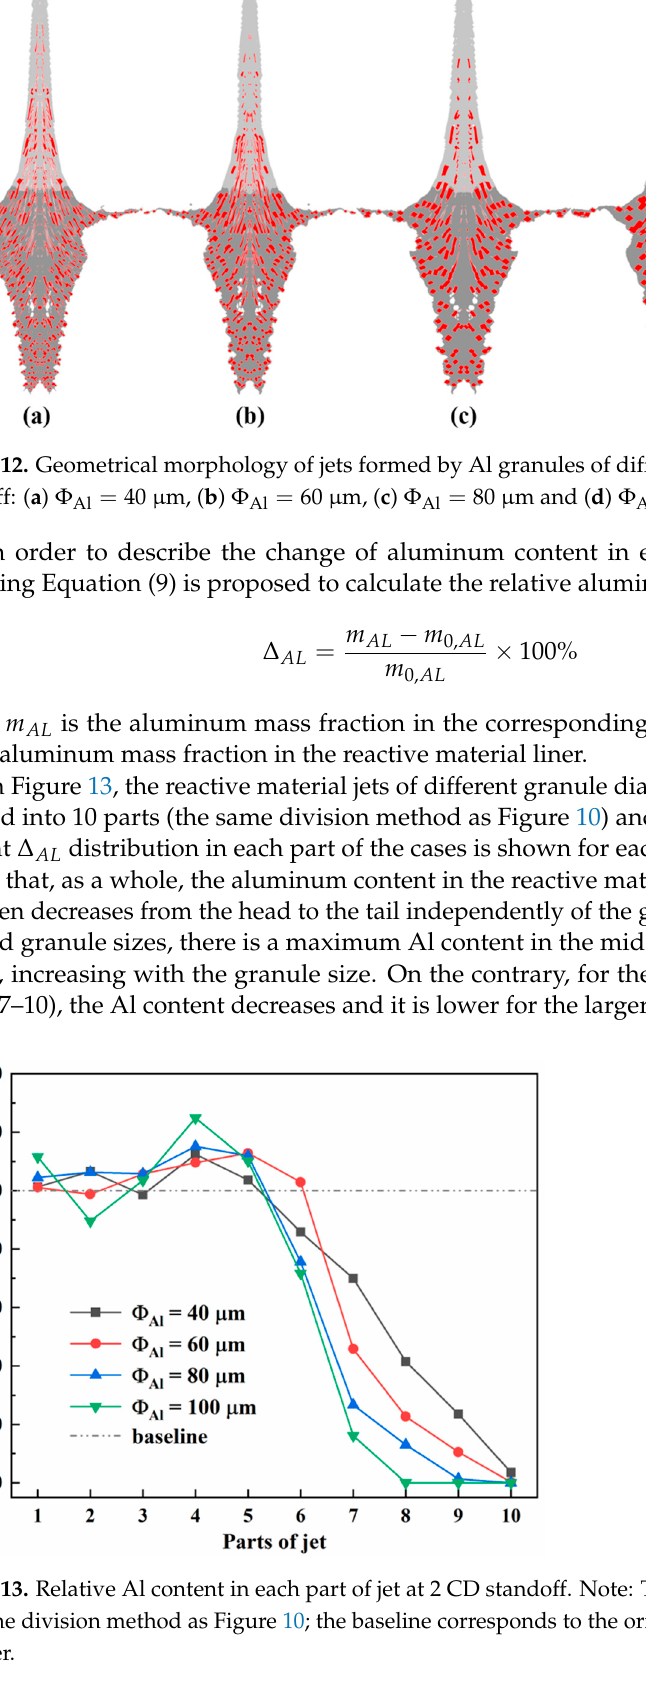
content in the liner. the